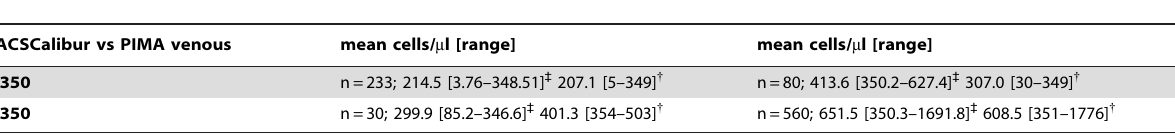
Table 4. CD4 Ranges by Instrument used at 350 cells/ m l*.